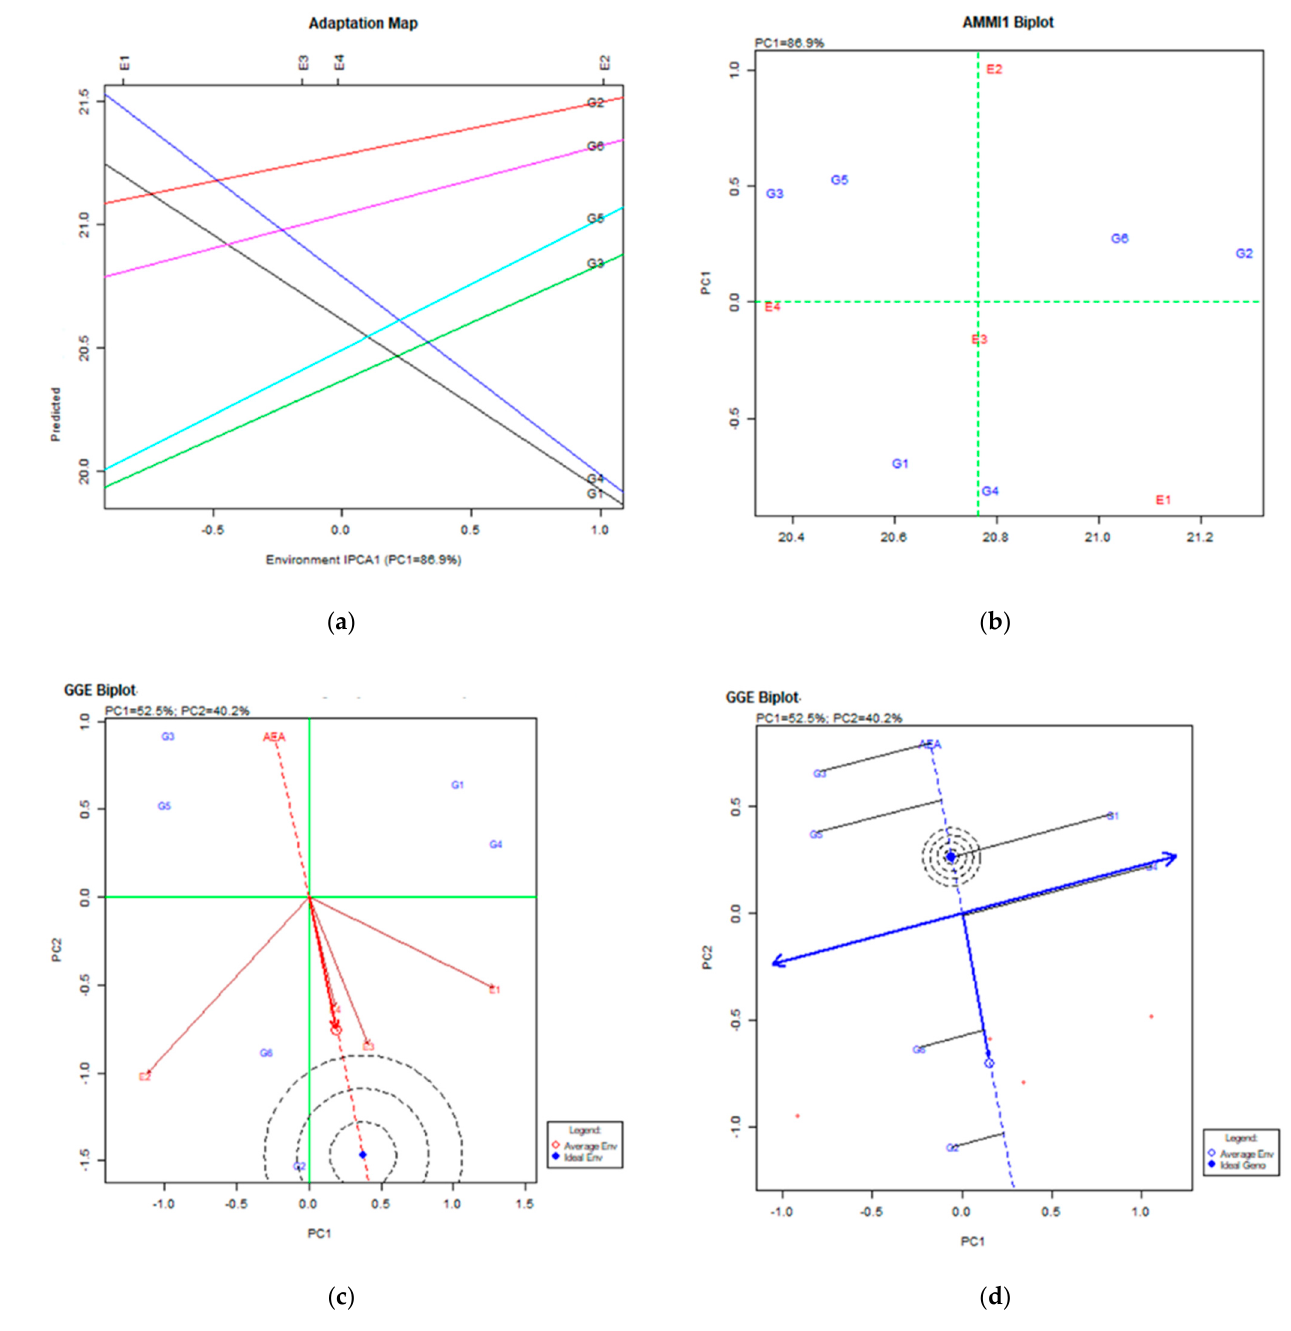
Figure 4. Stability analysis for crude protein content (%) based on: ( a ) the adaptation map where the X-axis (PC1) visualizes the stability of varieties over environments and the Y-axis—the performance of varieties for the trait; ( b ) the AMMI1 biplot where the Y-axis is the one visualizing the trait performance and the X-axis (PC1) visualizes the stability of varieties over environments; ( c ) the GGE biplot for environments depicting the stability of the environments over years via the placement as near as possible to the ideal and average environment; ( d ) the GGE biplot for varieties depicting the stability of the varieties over environments where the productive varieties are those to the right on the AEA vector and the stable ones are those which are as close to the AEA axis as possible.